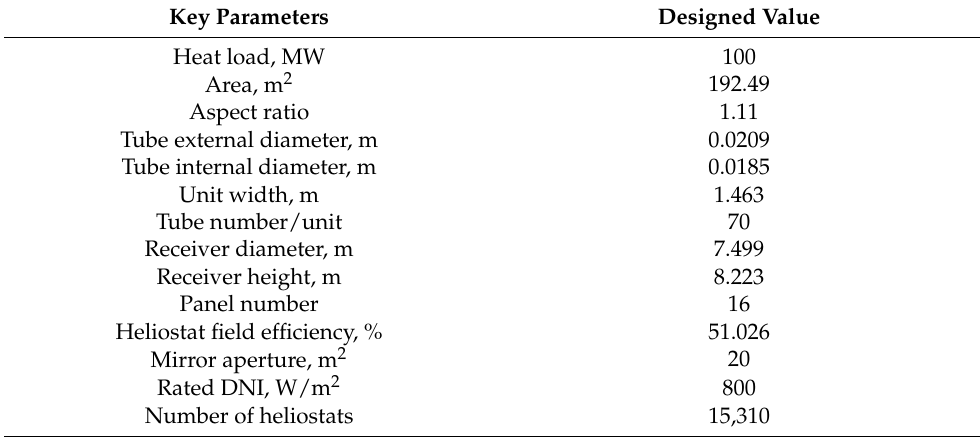
Table 1. Receiver parameters.